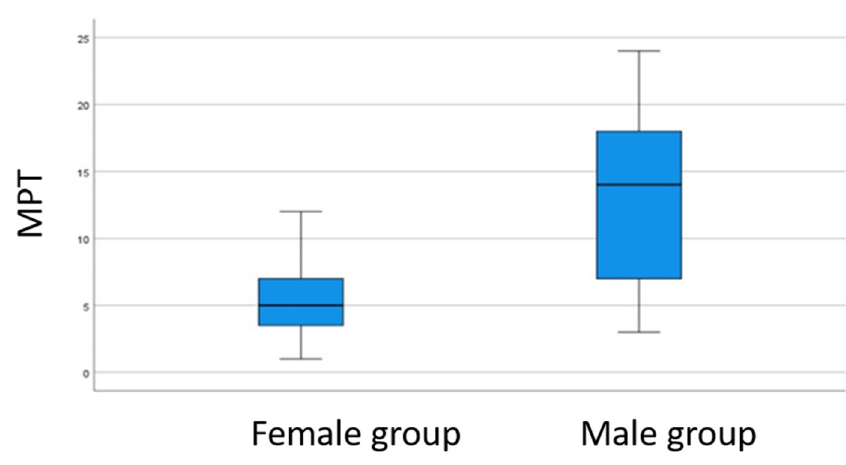
Figure 6. Comparison of the MPT values between gender groups. A significantly higher increase